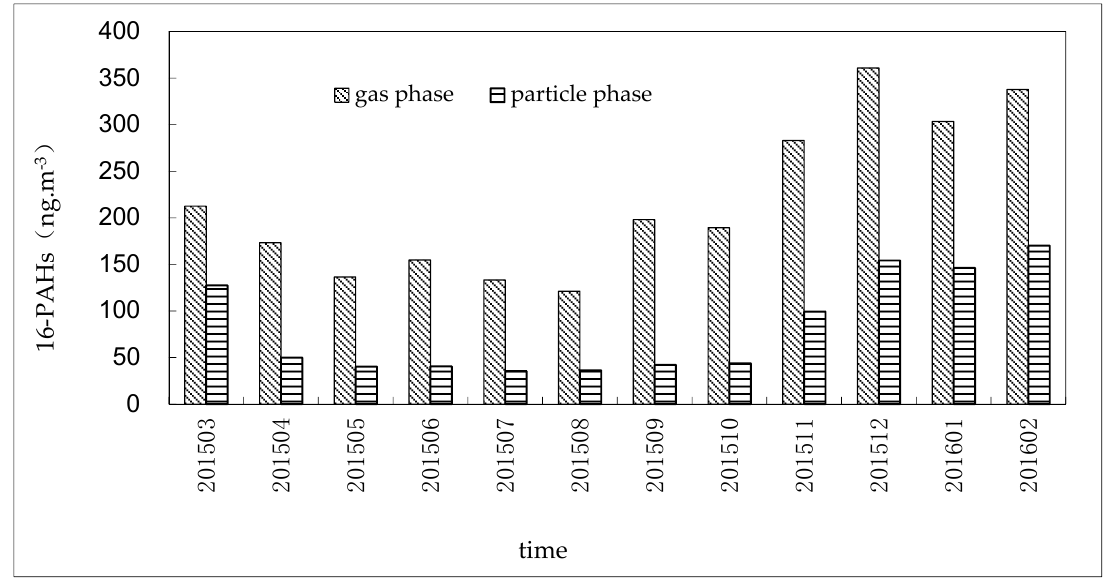
Figure 1. Atmospheric PAHs gas-particle concentration distribution in Chengdu. Table 1. Mean concentration (ng·m − 3 ) and standard deviation for total, gaseous, and particulate PAHs during four different seasons of one year in air samples from Chengdu.